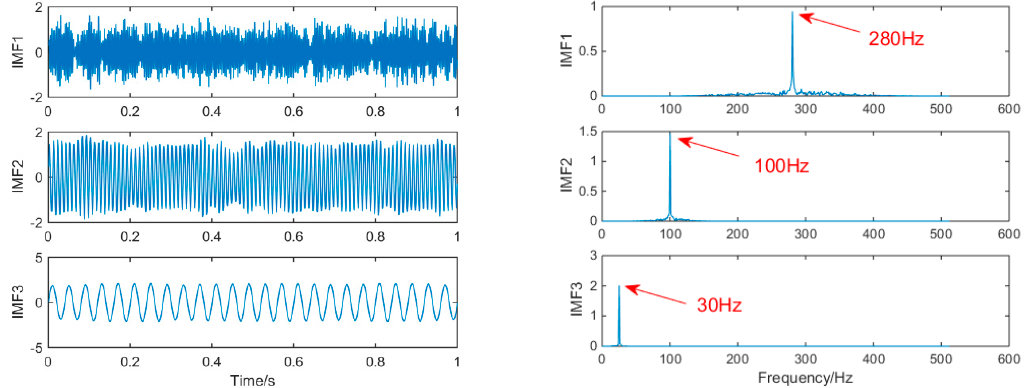
Figure 5. The spectrum of IMFs after MSSD and its corresponding spectrum.